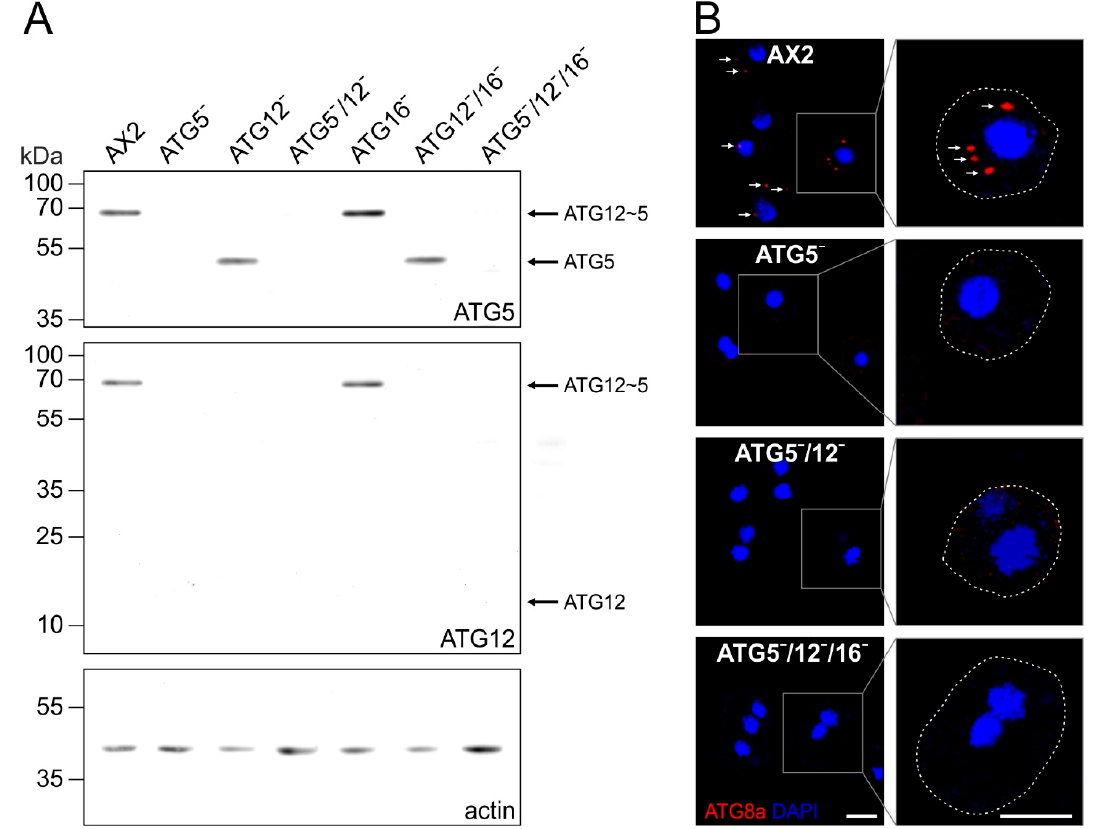
Figure 3. Verification of the different mutant strains by immunoblotting and immunofluorescence analysis of ATG8a-positive autophagosomes. ( A ) Immunoblotting of total cell lysates of wild-type AX2, ATG5¯, ATG12¯, ATG5¯/12¯, ATG16¯, ATG12¯/16¯, and ATG5¯/12¯/16¯ cells. The ATG12~5 conjugate was detected at about 68 kDa in AX2 and ATG16¯ cell lysates but not in atg5 and atg12 knock-out strains. Unconjugated ATG5 of about 46 kDa was detected in ATG12¯ and ATG12¯/16¯ cells. No unconjugated ATG12 of about 14 kDa was detectable. Actin was used as a loading control. ATG5, ATG12 and actin were visualised on the same membrane. Top row, ATG5 pAb; middle row, ATG12 mAb; bottom row, actin mAb. ( B ) Immunofluorescence microscopy of AX2, ATG5¯, ATG5¯/12¯ and ATG5¯/12¯/16¯ cells. Cells were fixed with cold methanol and stained with the ATG8a pAb. Puncta representing ATG8a-positive autophagosomes (arrows) were only detected in AX2 wild-type cells. Cell boundaries in the enlarged insets are indicated by dotted lines. Nuclei were visualised by DAPI staining. Scale bar, 5 µm.